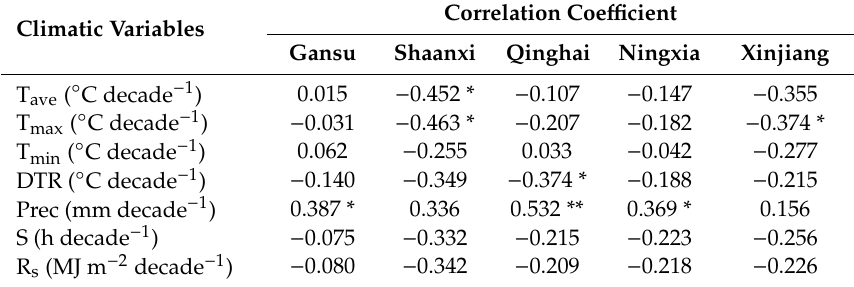
Table 4. Correlation coefficients between climate-induced potato yield and key climatic variables. Climatic Variables